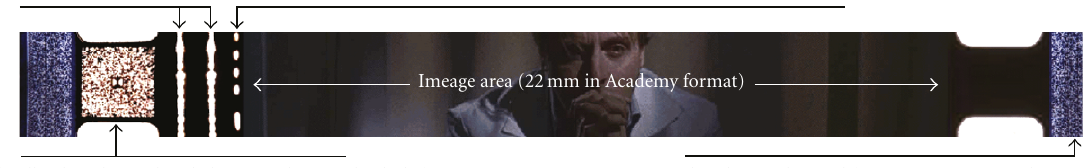
Figure 1: 35mm film strip showing modern digital soundtracks among the analog VA soundtrack.